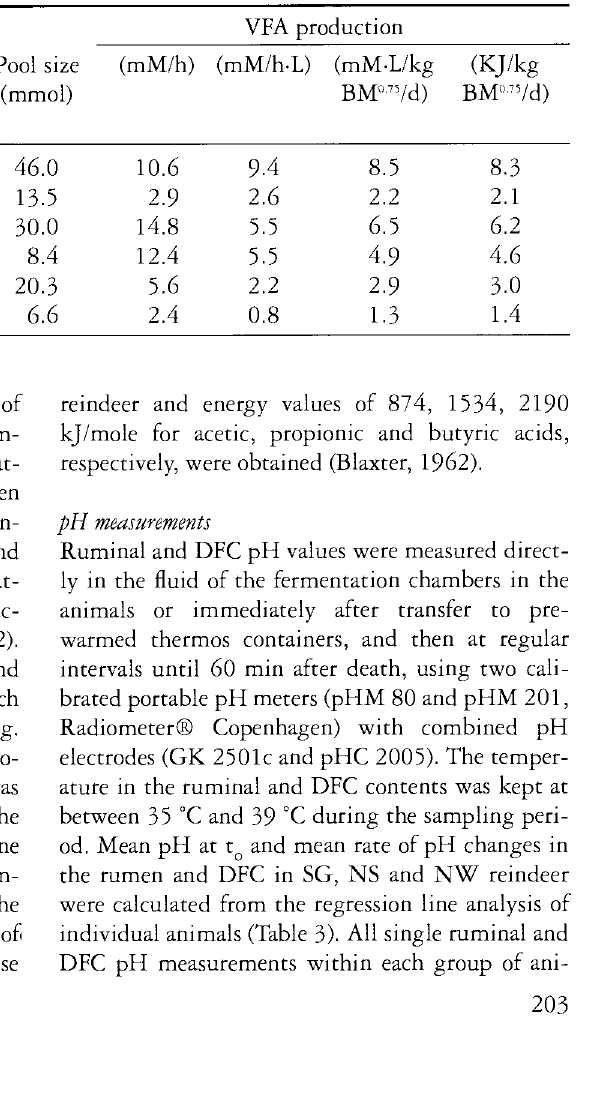
Table 2. Mean (s = standard deviation) body mass, fluid volume of distal fermentation chamber (DFC), volatile fatty acids concentration (VFA), pool size and production rates in reindeer (Rangifer t. tarandus) on South Georgia (SG) in summer (n = 3), in northetn Norway in late summer (n = 3) (NS) and in winter (n = 6)